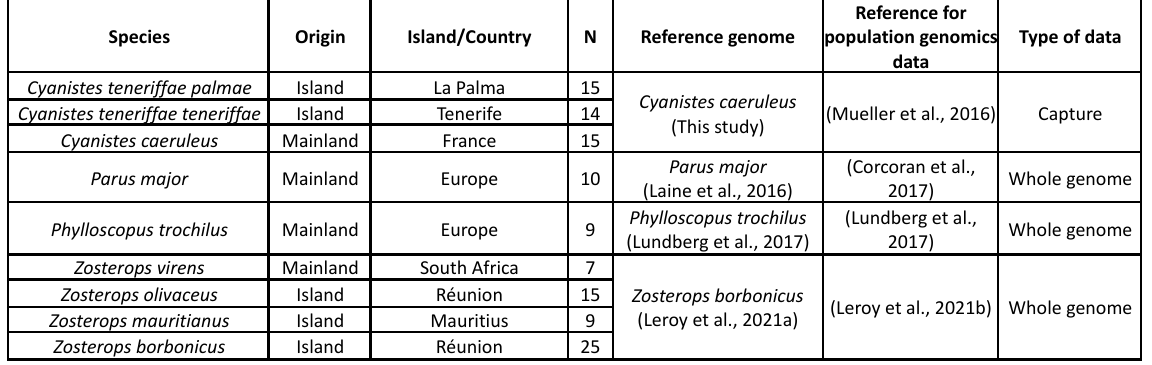
Table 1: List of species and sampling localities, along with the type of data obtained and the number of individuals